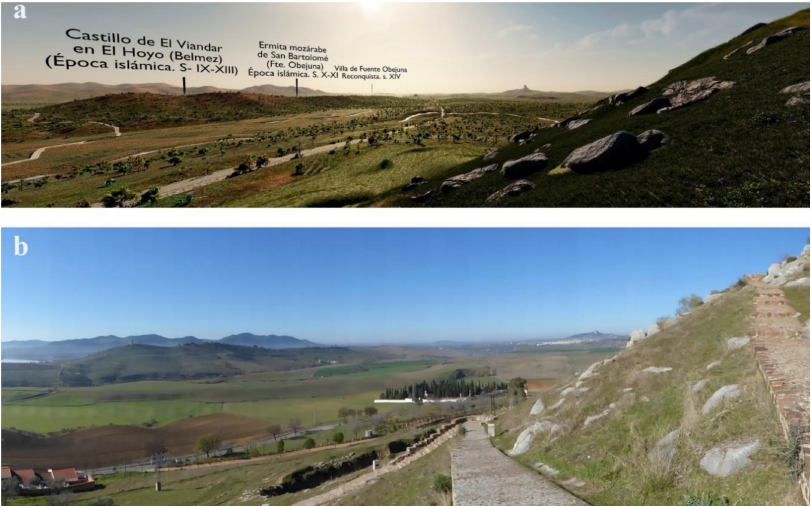
Figure 11. Area surrounding the CCB shown using VR. View to NW: ( a ) medieval landscape; ( b ) current view. Images from Lithodomos VR for “Ager Mellariensis” / AEI FEDER HAR